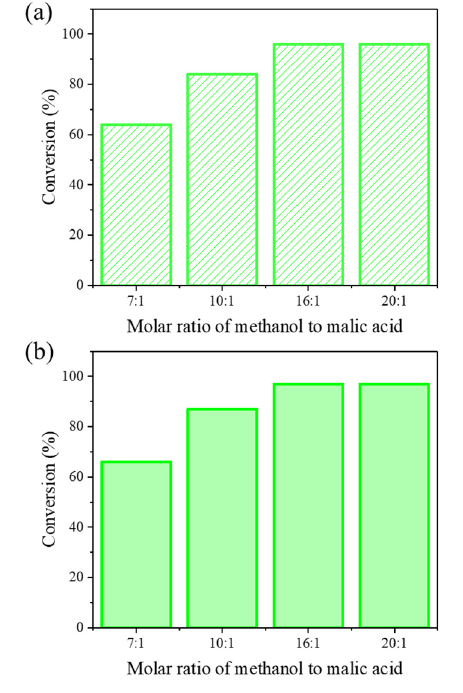
Figure 6. Effect of molar ratio of methanol to malic acid on the conversion of malic acid over ( a ) Zr(SO 4 ) 2 / SiO 2 and ( b ) Zr(SO 4 ) 2 / AC catalysts. Reaction conditions: Malic acid amount (1 g), catalyst amount (0.1 g), reaction time (2 h), reflux temperature, stirring speed (600 rpm).